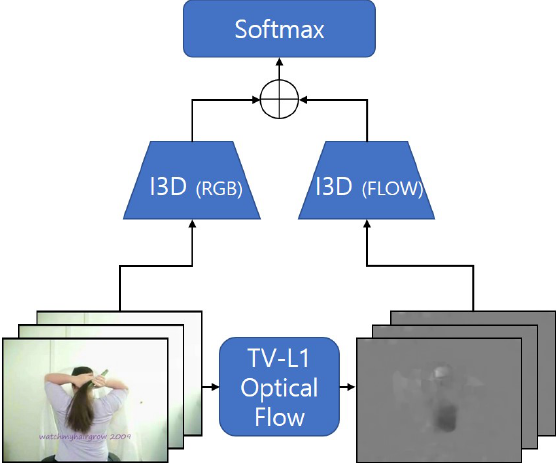
Figure 1. The overall architecture of